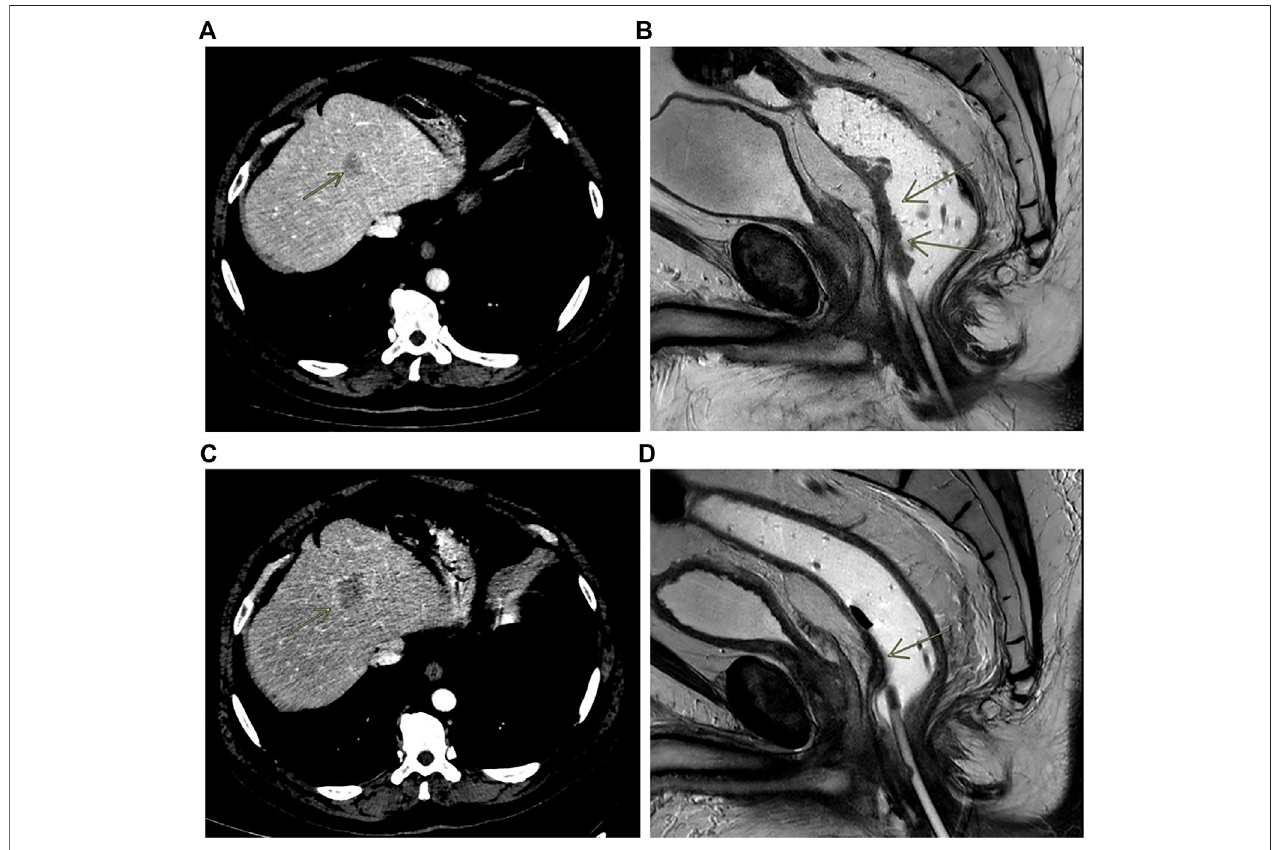
FIGURE 3 | Contrast enhanced CT scan showing liver metastasis at baseline (A) and at progression (C) ; MRI rectal cancer at baseline (B) and after treatment (D) .